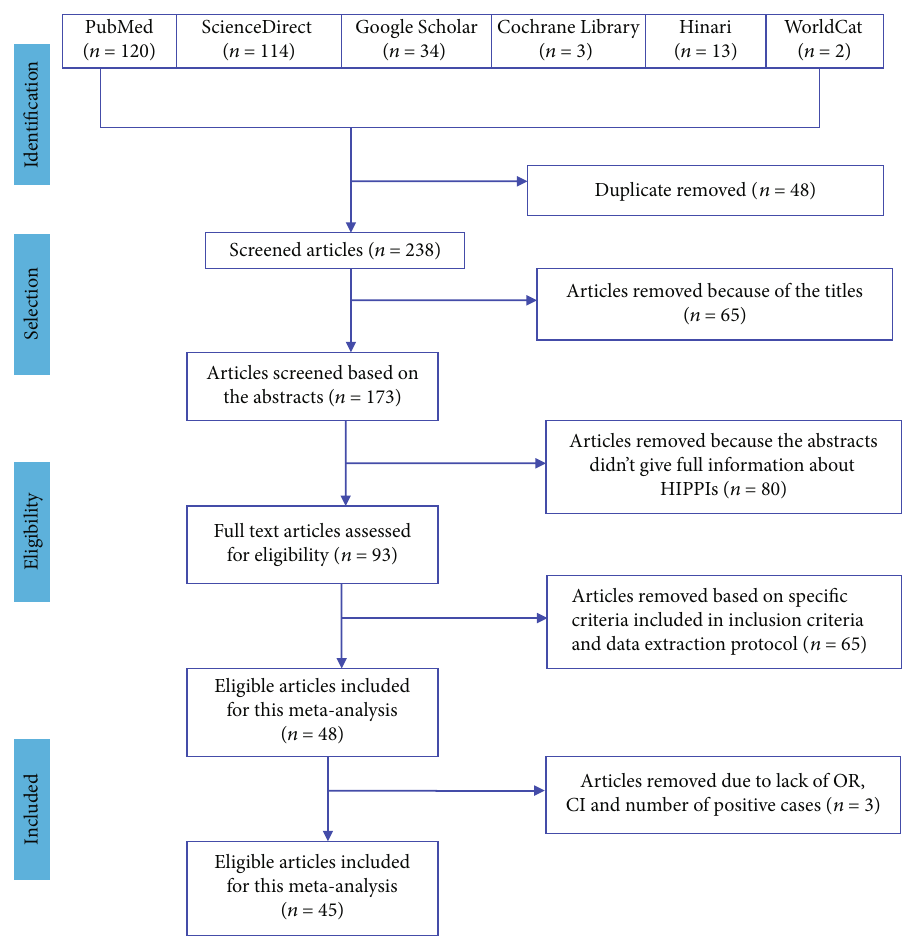
Figure 1: PRISMA fl ow diagram of articles considered for the review on HIPPIs among the Ethiopian